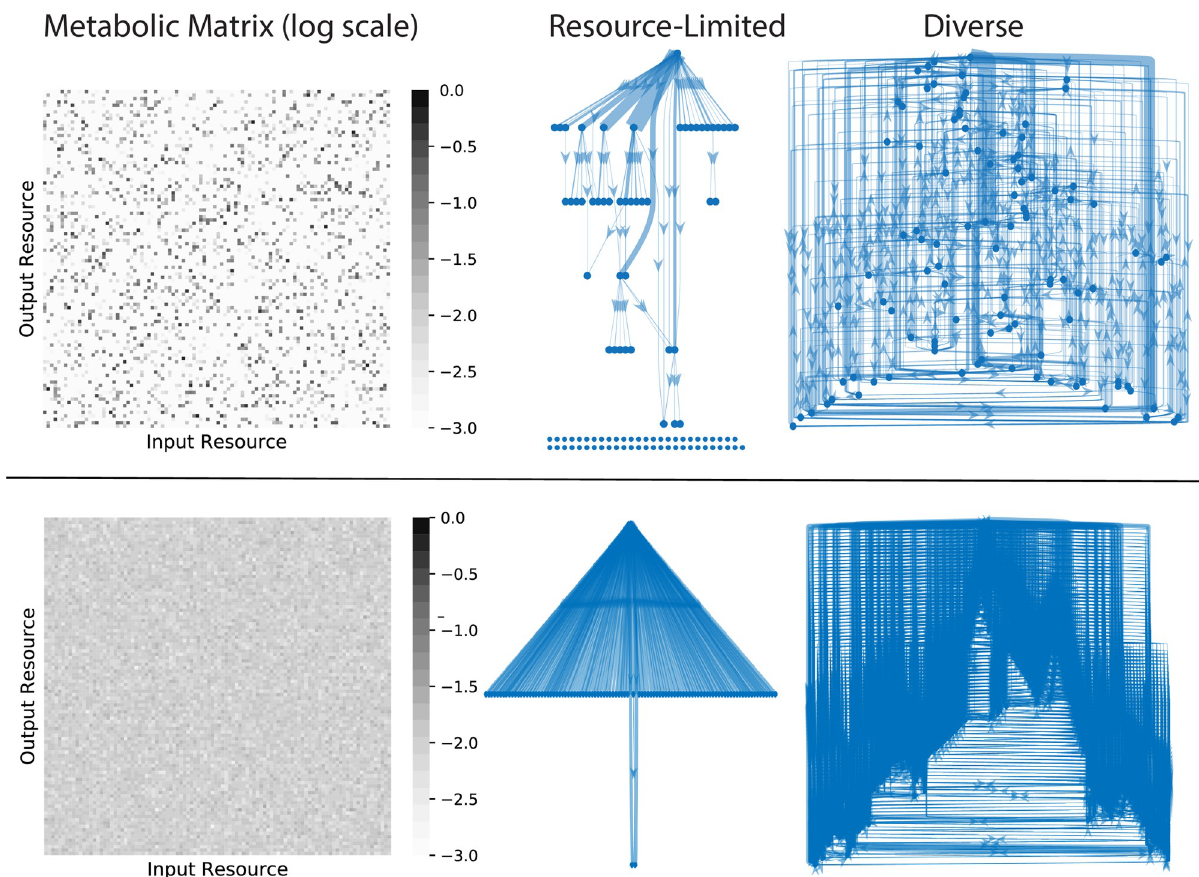
Fig 3. Energy flux networks differ in the two regimes. Community-scale energy flux networks are plotted for a characteristic example from the diverse and resource limited regimes and two different choices of metabolic matrix D αβ . The color of each pixel in the heat maps indicates the logarithm (base 10) of the corresponding matrix entry. In the networks, each node represents one of the M = 100 resource types. Edges represent steady-state energy flux from one resource type into another, mediated by consumer metabolism and leakage/secretion. The thickness of each edge is proportional to the flux magnitude, and edges with magnitudes less than 1% of the maximum flux are not displayed. The single node at the top of each graph is the externally supplied resource, and the rows of nodes at the bottom are resources that are not connected to the external supply by any flux above the 1% threshold. A topological analysis of the flux networks of all the simulated communities can be found in S10